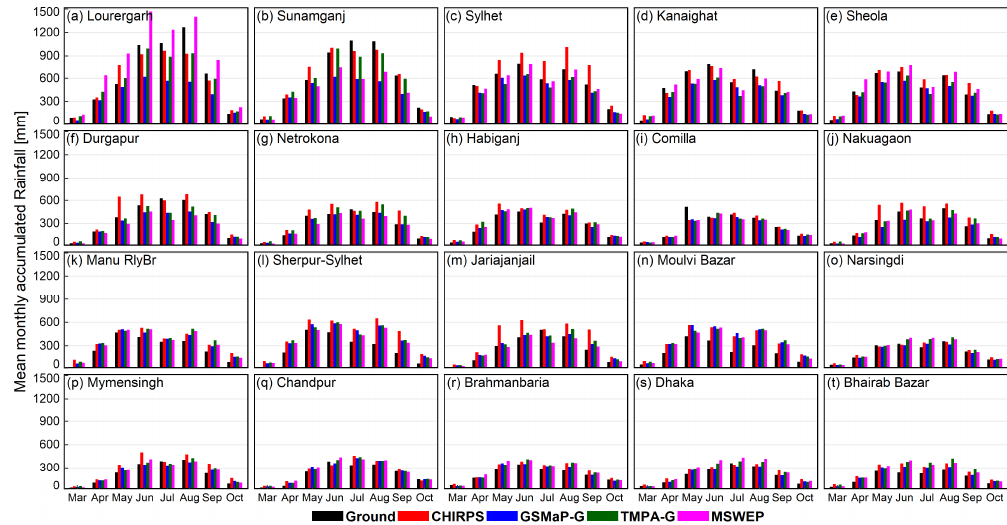
Figure 7. Mean monthly accumulated rainfall of the ground gauges and CHIRPS, GSMaP-G, TMPA-G, and MSWEP for the months of the rainy season (March–October) during the study period (2009–2016) at 20 gauge stations ( a – t ).